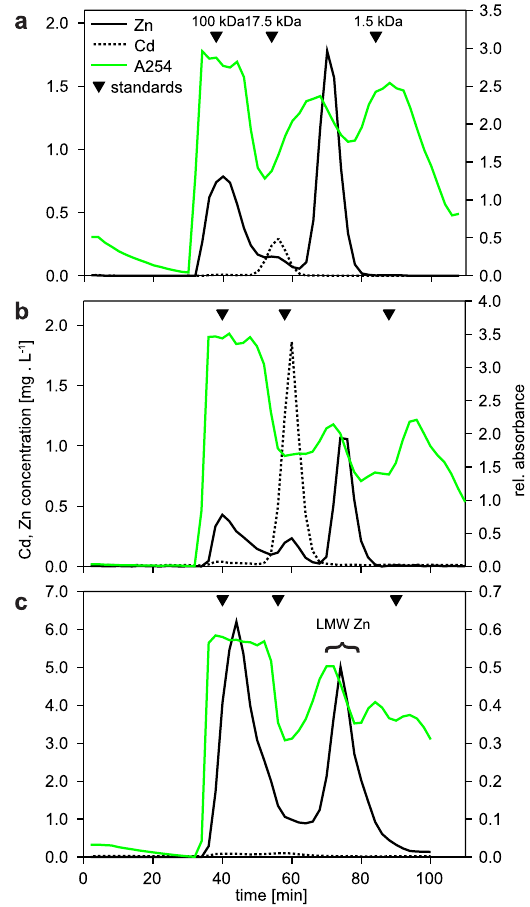
Figure 3. Gel permeation chromatography (Sephacryl S-100, 25 × 300 mm) profiles of midgut gland homogenate supernatants from control ( a ), Cd ( b ) and Zn-exposed Arion vulgaris ( c ), showing absorptions 254 nm (green line), as well as concentrations of Cd (dotted line) and Zn (black line), as specified in ( a ). Elution peaks of calibration standards (blue dextran, ≥ 100 kDa; myoglobin, 17.5 kDa; and vitamin B12, 1.4 kDa) are marked by inverted black triangles above the elution profiles. Fractions collected and pooled for subsequent purification (Fig. 4c) are indicated by brace and LMW Zn